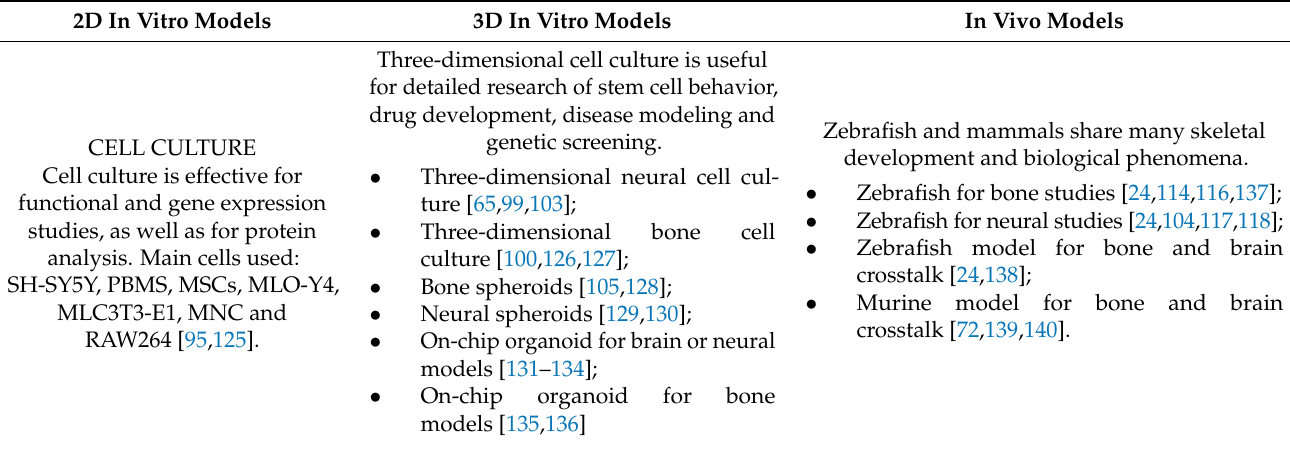
Table 1. Several in vitro and in vivo models used in skeletal and neuronal studies. 2D In Vitro Models 3D In Vitro Models In Vivo